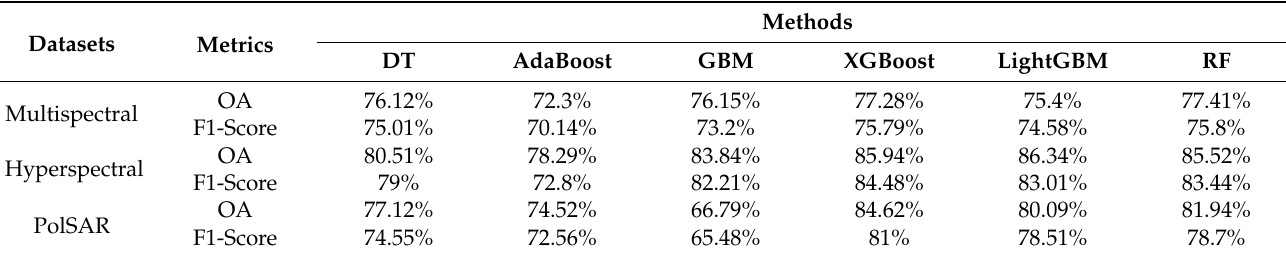
Figure 19. Numerical evaluation of EL techniques in the classification of San Francisco data. Table 12. Comparison between the performance of different methods on the classification of multispectral, hyperspectral, and PolSAR